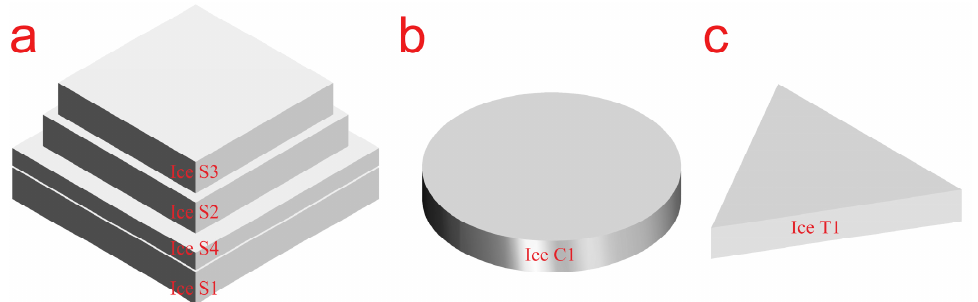
5 of 16 Figure 2. Illustration of the Euler overlay method. 2.4. Numerical Model Ice Three model ice shapes, square, circular and triangular, were used in the numerical calculation, as illustrated in Figure 3. Table 1 presents the parameters of model ice. Table 1. Model ice parameters.